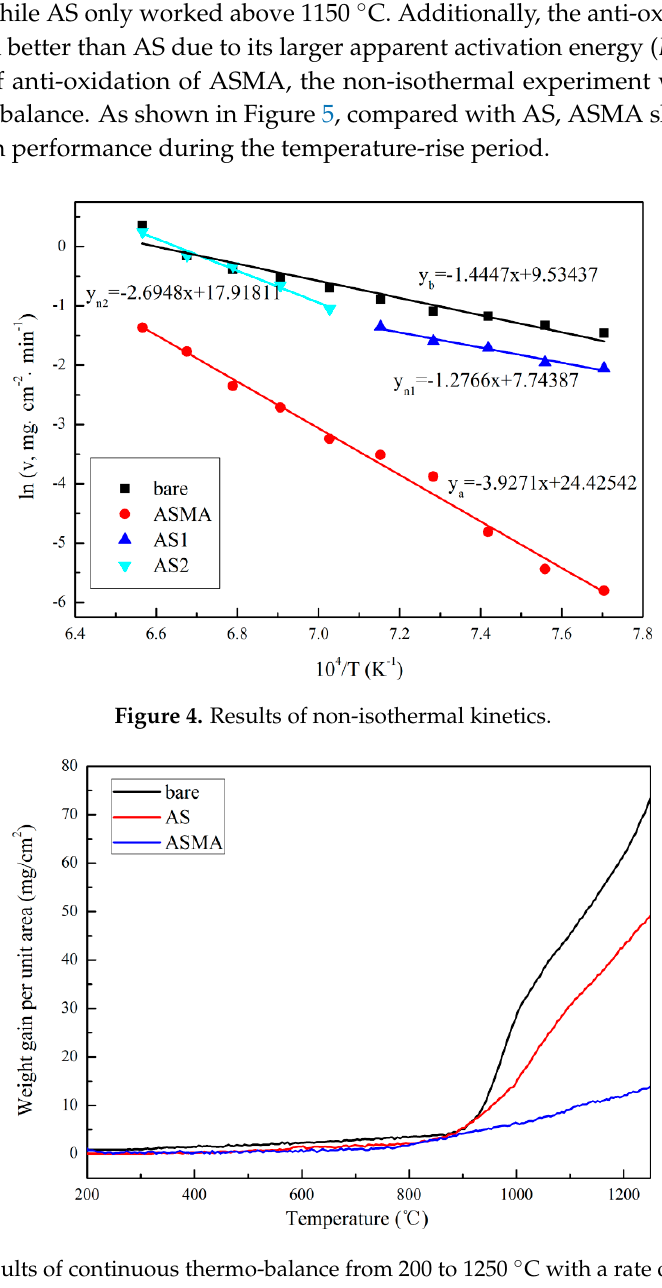
Figure 5. Results of continuous thermo-balance from 200 to 1250 °C with a rate of 10 °C/min.